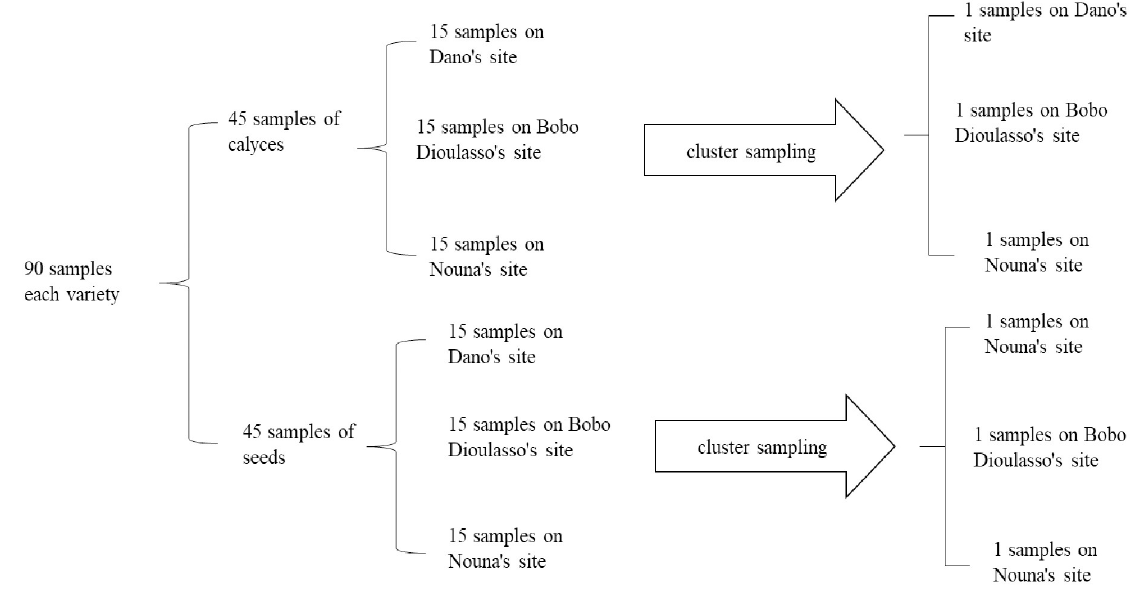
Fig 1. Experimental